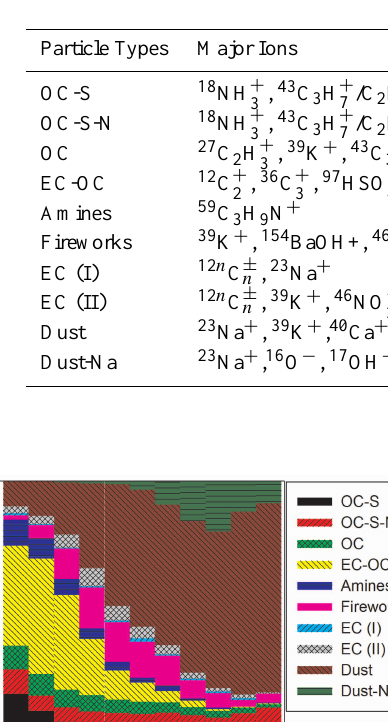
Table 4. Major ion markers of the 10 major particle types in Harrow.